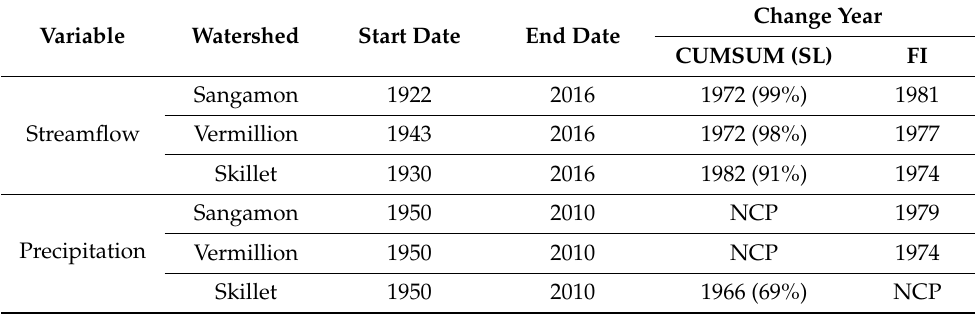
Table 2. Change point analysis for annual runoff and precipitation time series for CUMSUM and FI methods for Sangamon, Vermillion, and Skillet, where SL and NCP represent a significance level and a no change point,